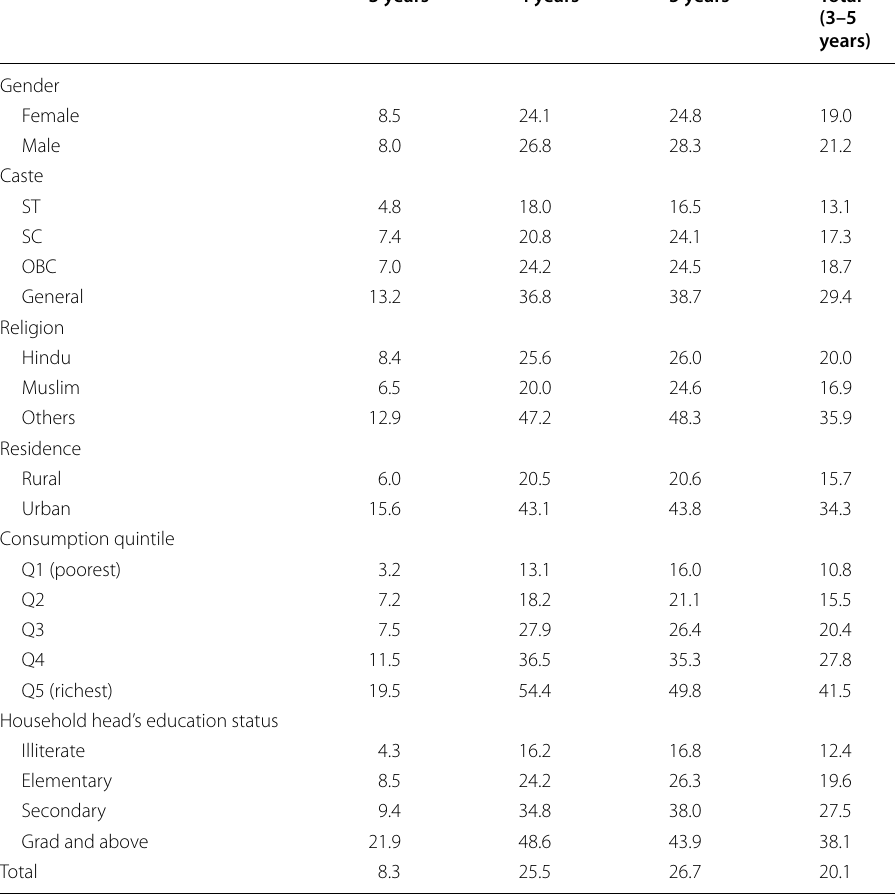
Table 3 Percentage of population attending pre-primary education in India by age and socioeconomic